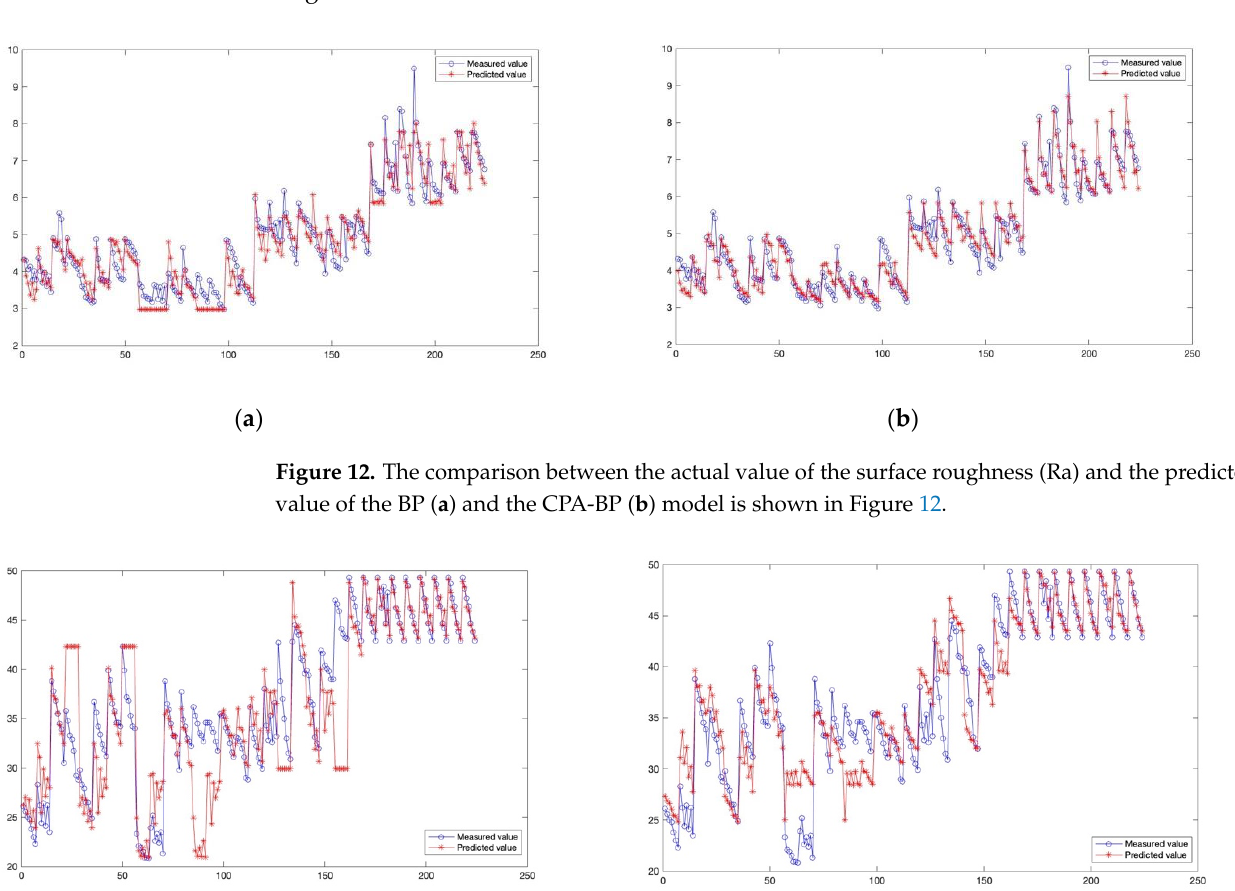
( b ) Figure 14. The comparison diagram of the prediction error of the BP neural network model and the CPA-BP model for the surface roughness ( Ra(a) and Rmax(b) ) of plywood. Since the traditional random forest algorithm can only have one predicted output value, the prediction result of the scotch pine tree species is selected here as a